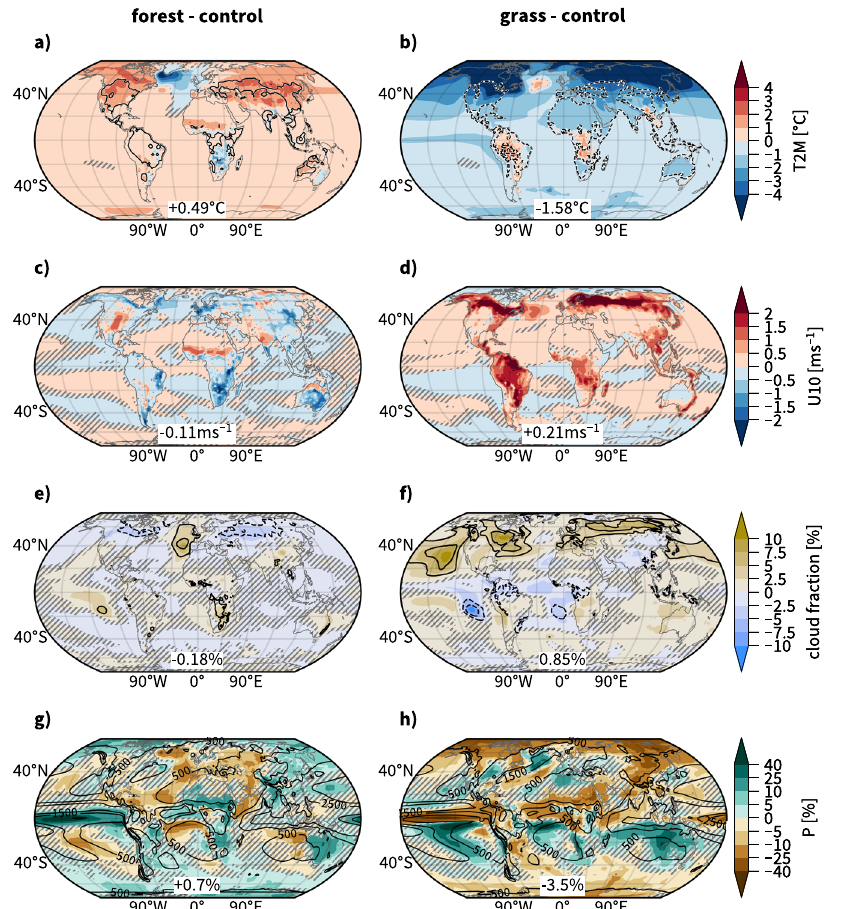
Fig. 1 | Changes of variables relevant to near-surface weather and climate. Panels( a , c , e , g )showchangesin forest and b , d , f , h changesin grass comparedto control . Variables shown are ( a , b ) absolute changes of annual mean 2m tem- perature (T2M, shading, in °C) and the number of days with a maximum tem- perature above 30°C (heat days, +15 days in solid contours and − 15 days dashed) and c , d absolute changes of annual mean 10m wind speed (shading, in ms − 1 ),